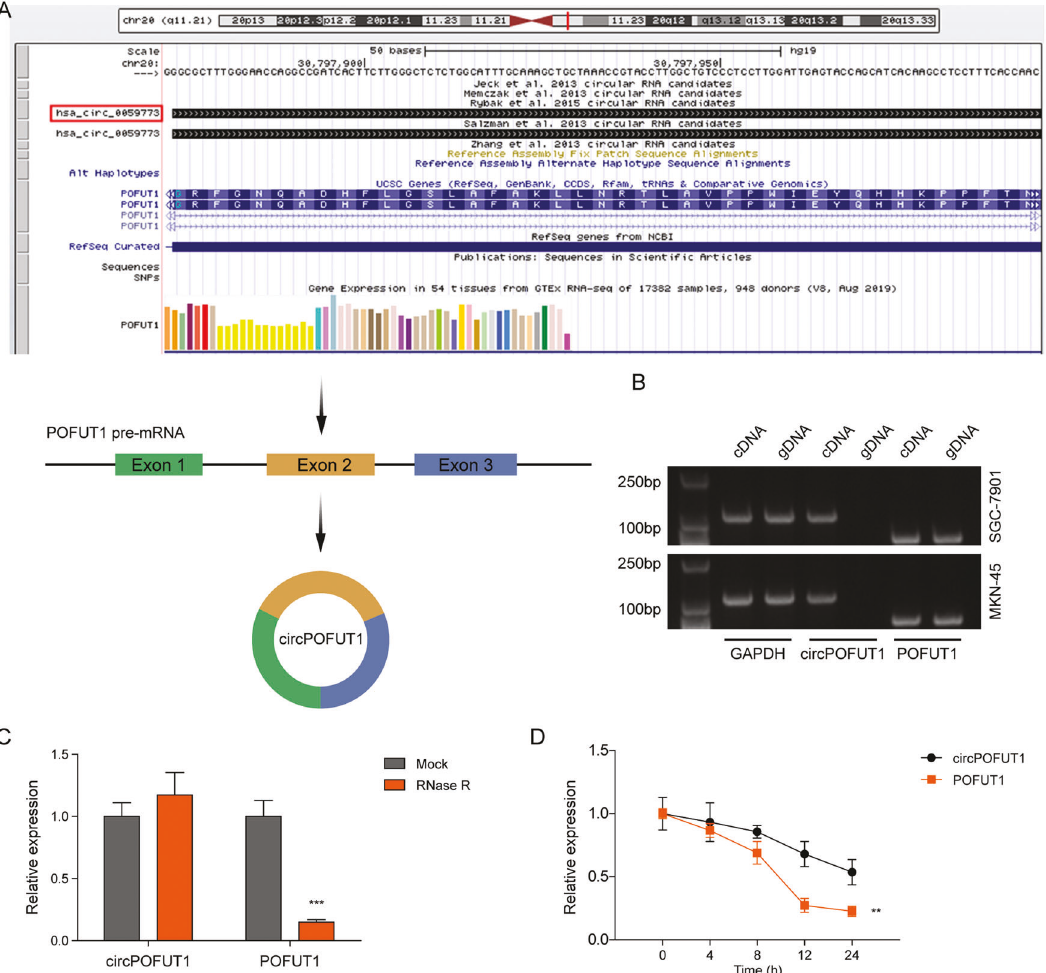
Fig. 2 CircPOFUT1 characterization. A The schematic diagram illustrated the origination of circPOFUT1 from the exon2 of POFUT1 pre- mRNA. B RT-PCR was applied to examine circPOFUT1 in cDNA and gDNA using divergent and convergent primers. C RT-qPCR analysis of circPOFUT1 and POFUT1 mRNA in response to RNase R treatment ( n = 3). D The stability of circPOFUT1 and POFUT1 in response to actinomycin D ( n = 3). ** P < 0.01 and *** P < dots Less groups based on the median number of LC3 dots (Supplementary Fig. 1B), and LC3 dots More GC tissues showed